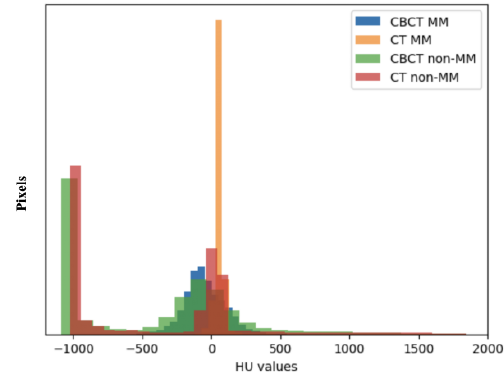
Figure 1. Hounsfield unit (HU) values distribution of the masseter muscle (MM) and non-masseter muscle (non-MM) regions in cone-beam computed tomography (CBCT) and computed tomography (CT).